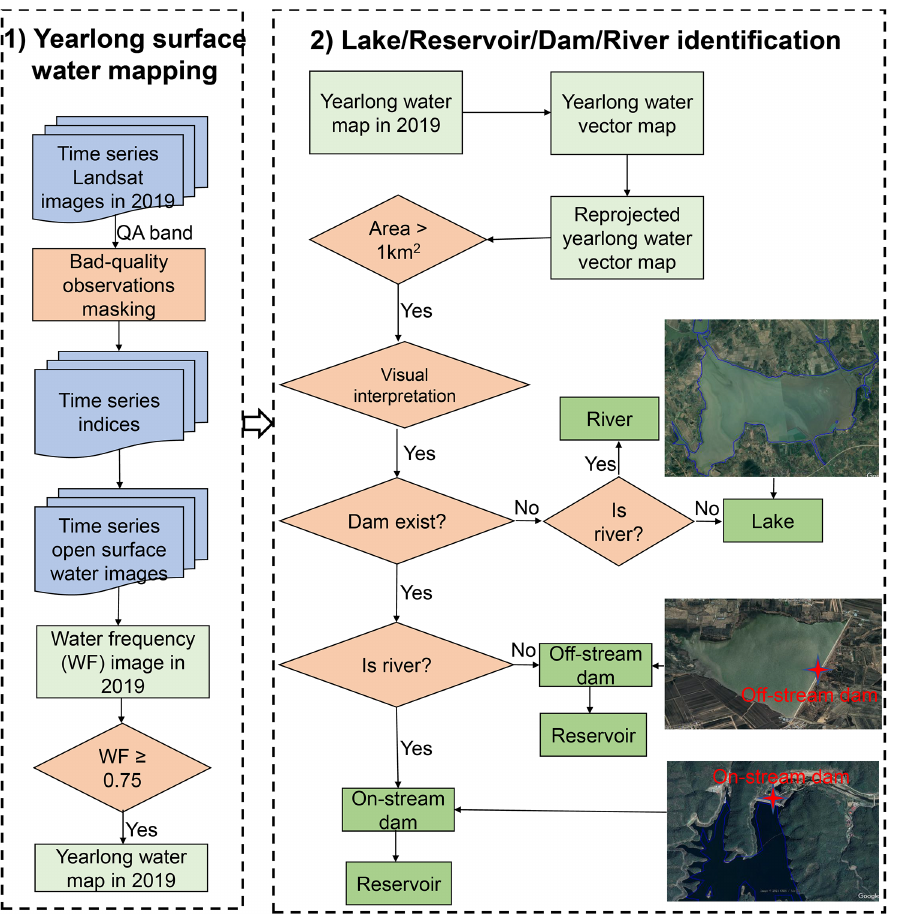
Figure 3. Schematic flowchart of lakes, reservoirs, dams, and rivers identification in this study. The images were acquired from Google Earth Pro (© Google Earth Pro